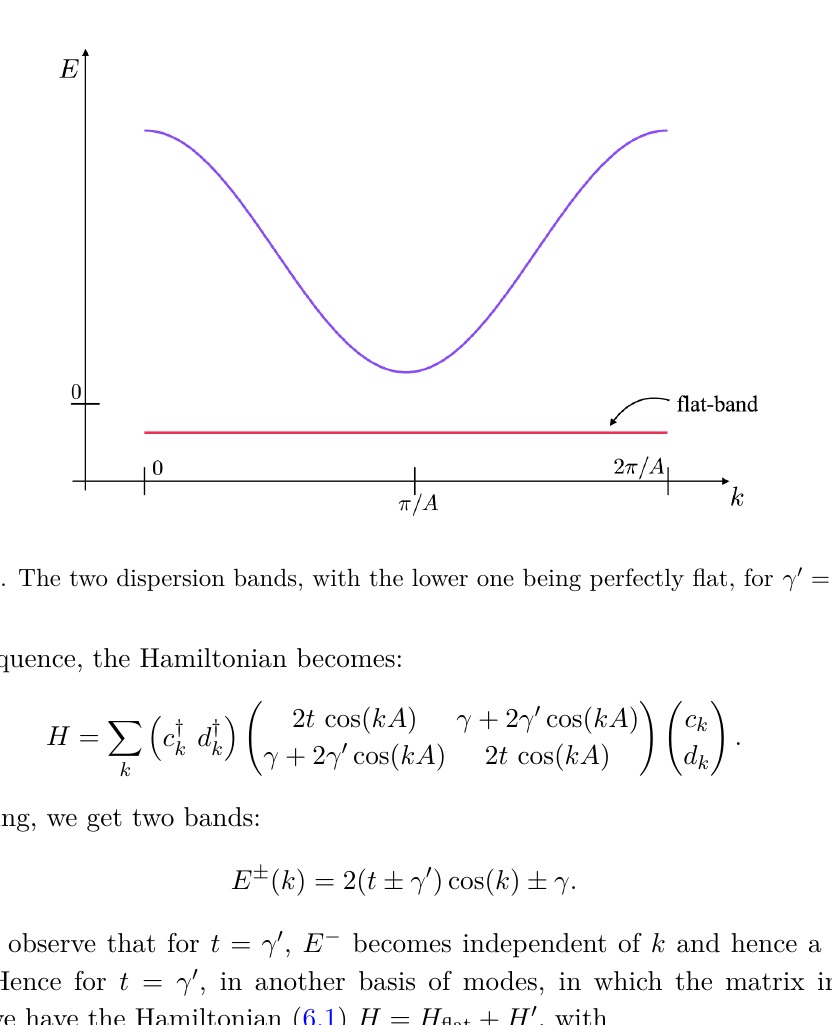
Figure 3 . The coupled chain system with all the intra-chain and inter-chain hopping strengths shown.